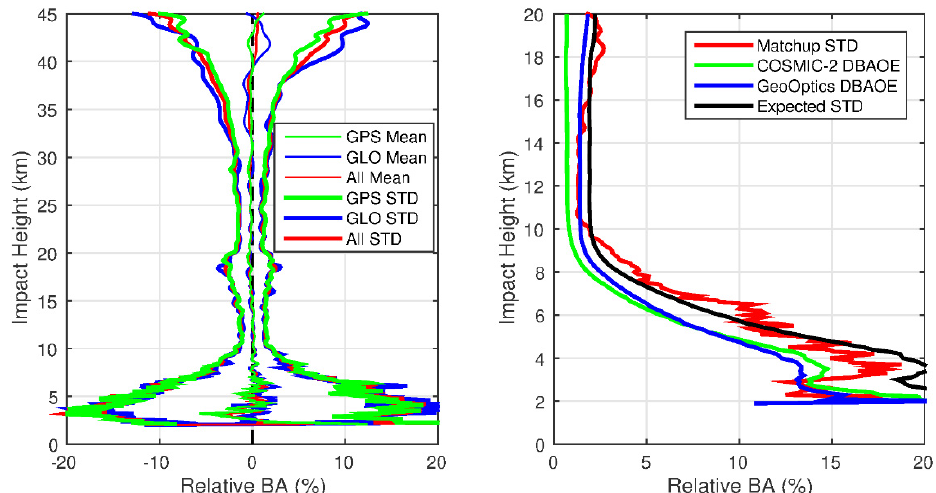
Figure 15. Bending angle profile statistics comparison between COSMIC-2 and GeoOptics for all 289 SRO cases (182 for GPS and 107 for GLONASS): ( left ) overall relative BA statistics (mean and standard deviation) comparison from GPS (green lines), GLONASS (blue lines), and GNSS satellites (red lines); ( right ) standard deviation comparison among overall matchup cases between GeoOptics and COSMIC-2 (red line), COSMIC-2 relative dynamic bending angle observation error (DBAOE) (green line), GeoOpitcs DBAOE (blue line) calculated from the bending angle retrieval process, and the expected standard deviation (see text). Table 1. Bending angle comparison (relative difference %) between GeoOptics and COSMIC-2 for GPS, GLONASS, and GNSS satellites. Only the bending angles from both COSMIC-2 and GeoOptics with valid data at the given impact height interval are included in the statistics. Impact Height (km)